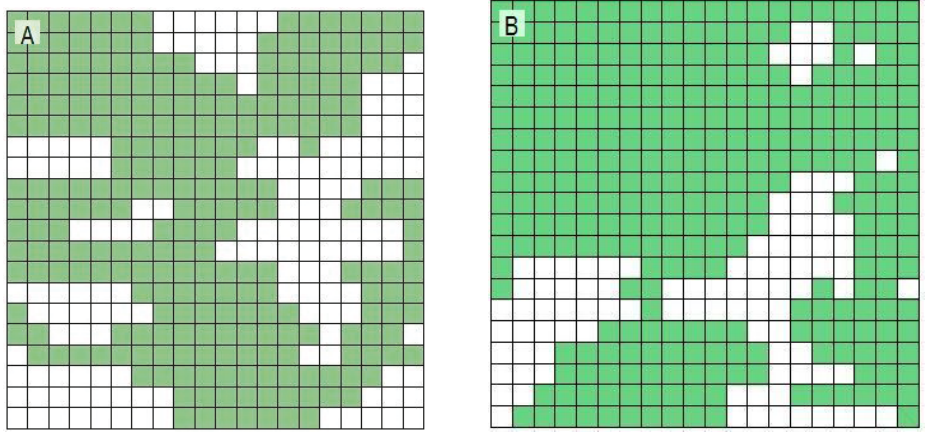
Figure 6. Covered area of perennial bed-mosses (from ’mixed’ mixture including 16 species, 63%, A ), and moss carpets (with Brachythecium rivulare and Calliergonella cuspidata , 76%, B ). Represented area: 1 x 1